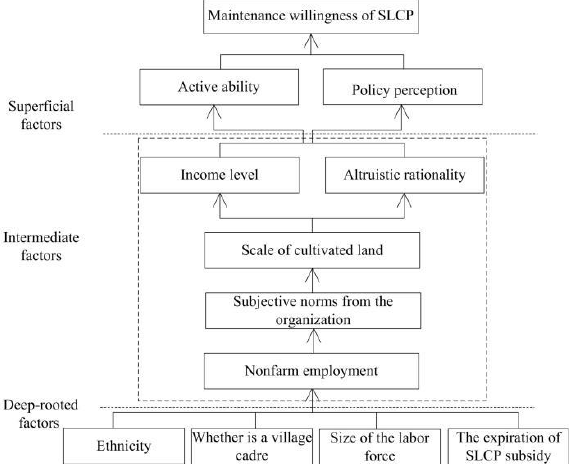
Figure 3. Interpretative structure model of the influencing factors.